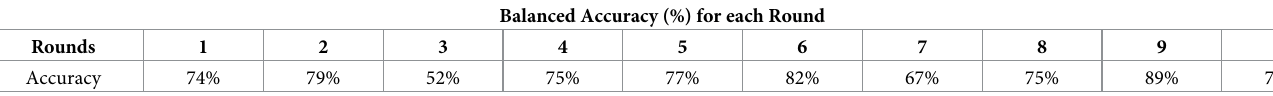
Table 1. Balanced accuracy of the classifier for each test